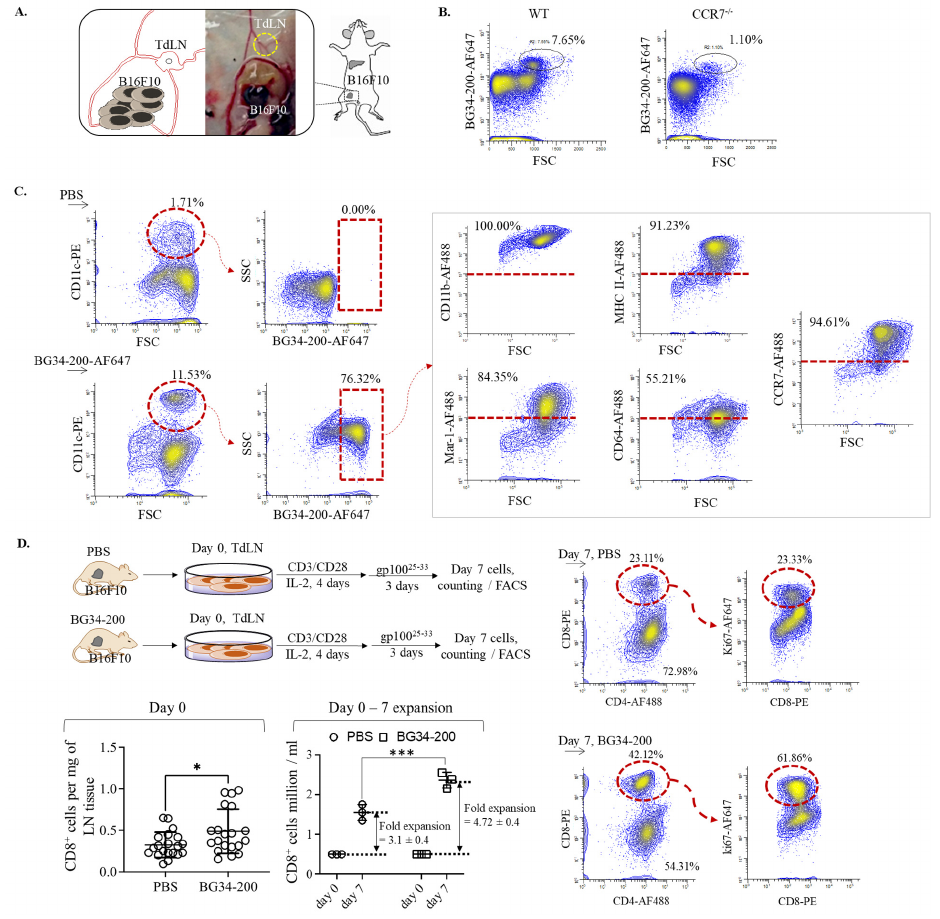
Figure 5. BG34-200-AF647 IV administration influenced cellular migration of mo-DCs and resulted in T-cell priming and expansion in TdLNs. ( A ). Schematics of harvesting TdLNs from B16F10 mice receiving BG34-200 IV administration. ( B ). FACS analysis of fluorescent signal of BG34-200-AF647 in WT and CCR7 − / − mice. ( C ). FACS analysis and phenotyping of BG34-200-AF647 + cells in TdLNs using PE-tagged CD11c and AF488-tagged CD11b, MHC II, Mar-1, CD64, and CCR7 biomarkers. ( D ). TdLNs harvesting from B16F10 tumor-bearing mice receiving PBS or BG34-200 compound IV injection and culture and expansion of T cells using activation beads in the presence of IL-2 recombinant cytokines. Total number of CD8 + cells in TdLNs on day 0 was determined by cell counting of trypan-blue-positive cells and FACS analysis of CD8 + cell frequency. The CD8 + cell expansion folds were determined by culturing 0.5 million CD8 + cells on day 0 and counting the total number of CD8 + cells on day 7. The TdLN-derived T-cell proliferation in response to gp100 25 − 33 peptides was determined by FACS analysis of the ki67 expression level in CD8 + T cells on day 7 cultures. *, p < 0.05, ***, p < 0.001.